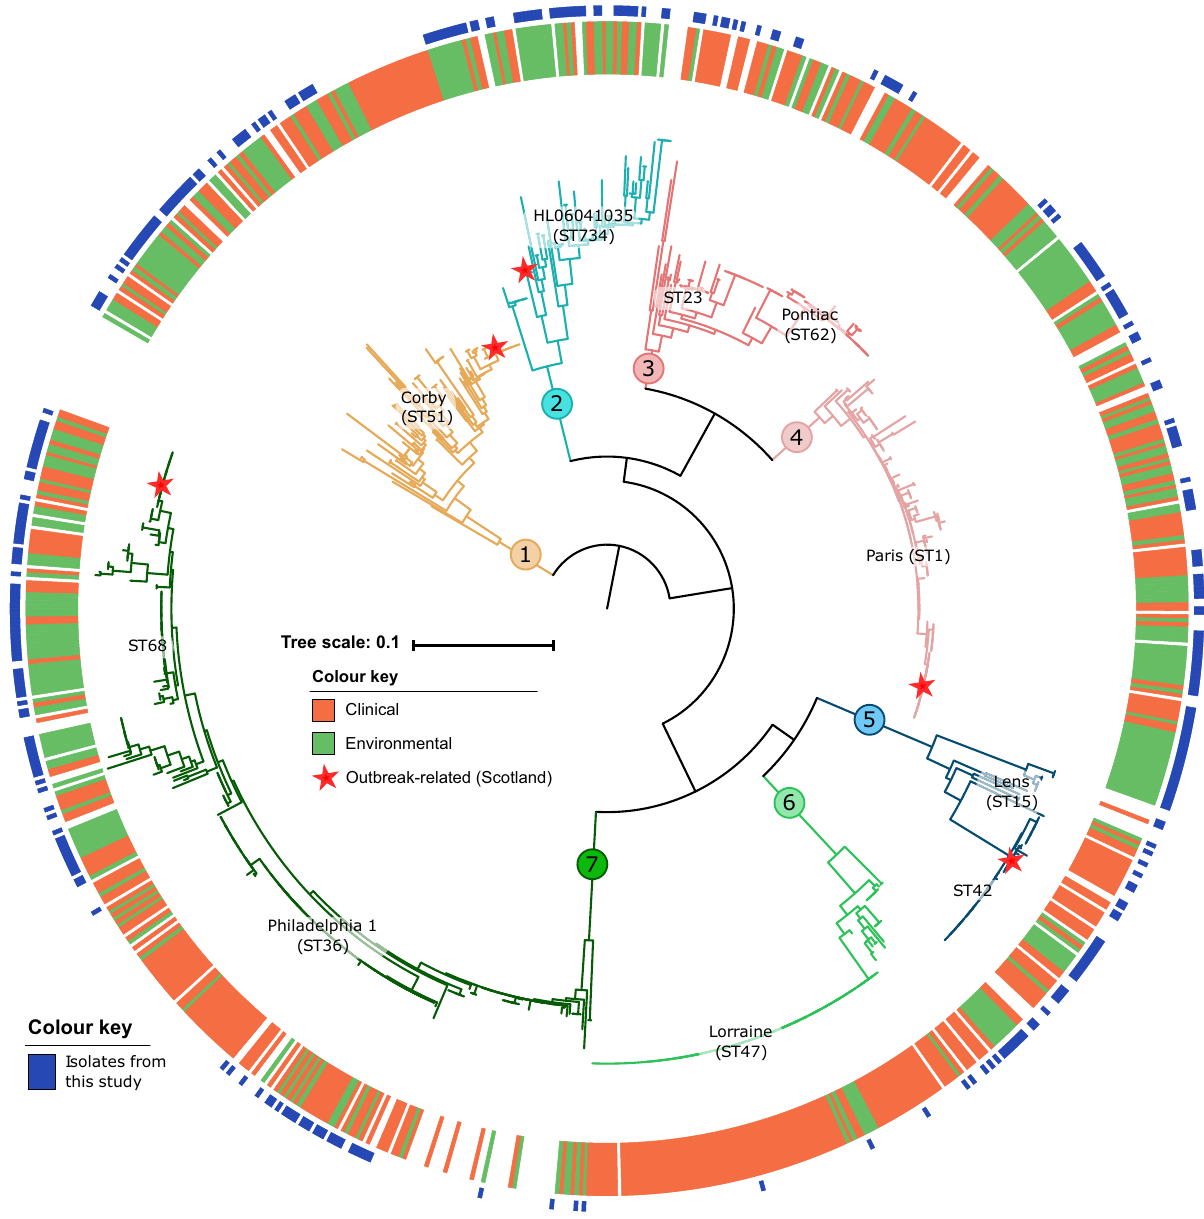
Fig. 1 Human clinical isolates of L. pneumophila are widely distributed across the global species diversity. A maximum-likelihood phylogeny of 902 isolates based on 139,142 core genome SNPs divides the subspecies into seven major clades that are also supported by BAPS clustering. Isolates linked to fi ve major outbreaks that have occurred in Scotland, UK between 1985 and 2012 originated from different lineages are indicated. In addition, isolates associated with sporadic cases of human infection have also emerged from diverse genetic backgrounds across all major clades. For reference, the position of fi ve major disease associated clones (ST1, 23, 36/37, 47 and 62) and well-characterised reference genomes are indicated. The tree scale indicates the number of subtitutions per